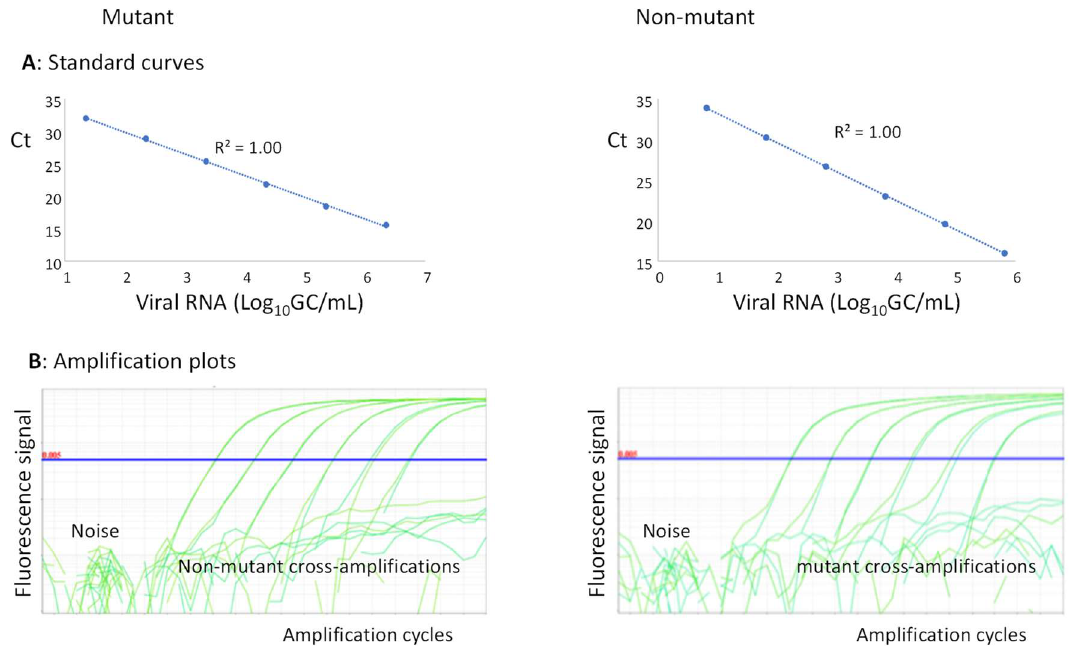
Figure 1. QmosRT-PCR assay: ( A ) standard curves and ( B ) amplification plots of mutants and non-mutants generated from viral RNA reference standards. Table 2. Quantification of nOPV2-c1_171 mutants in plasmid-spiked samples by qmosRT-PCR assay using plasmids as reference